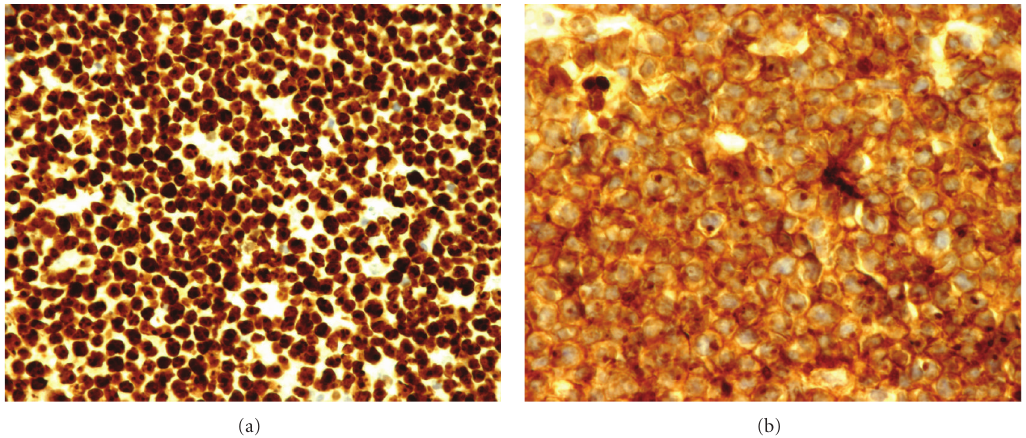
Figure 4: The proliferation rate (Ki67/MIB1) is 100% (a). The tumor cells expressed B lymphoid markers (not shown) with a coexpression of CD10